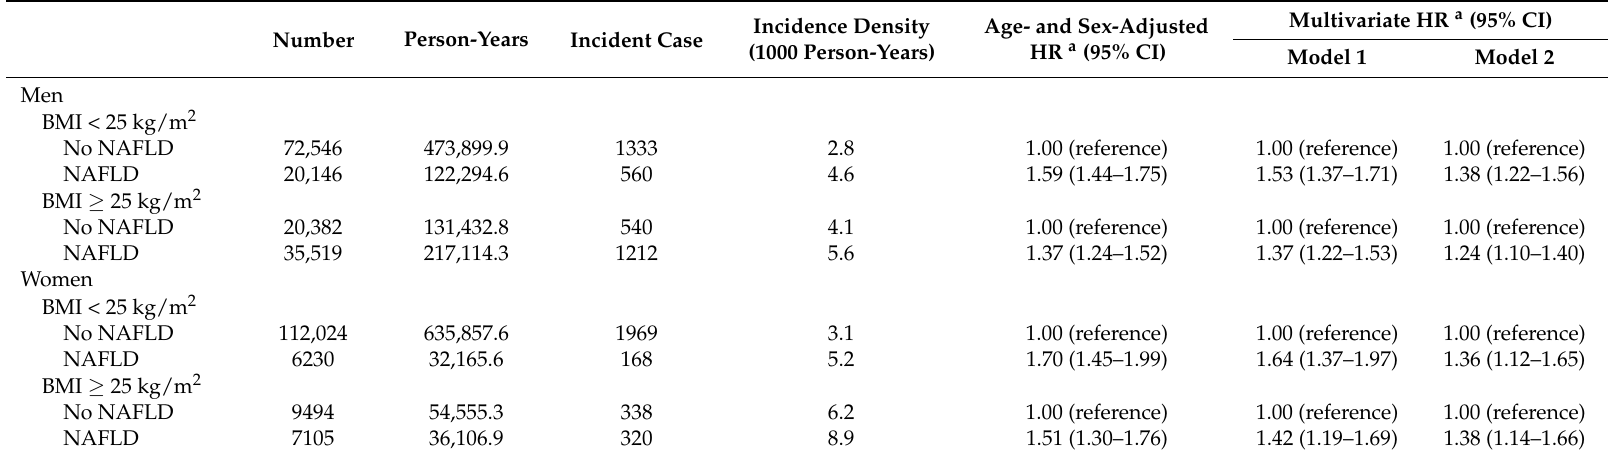
Table A1. The associations between nonalcoholic fatty liver disease (NAFLD) and development of gallstones by the presence of obesity, defined as BMI ≥ 25 kg/m 2